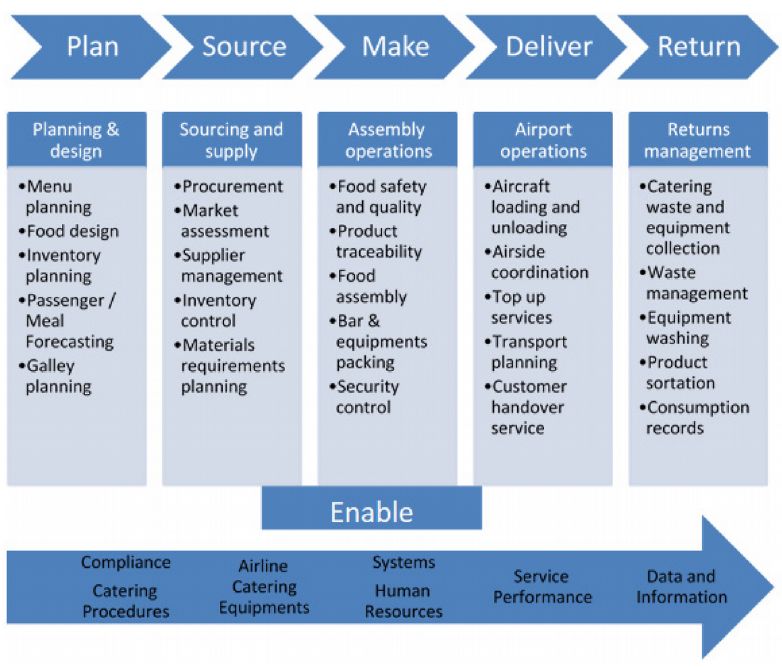
Figure 2. SCOR model of airline catering supply